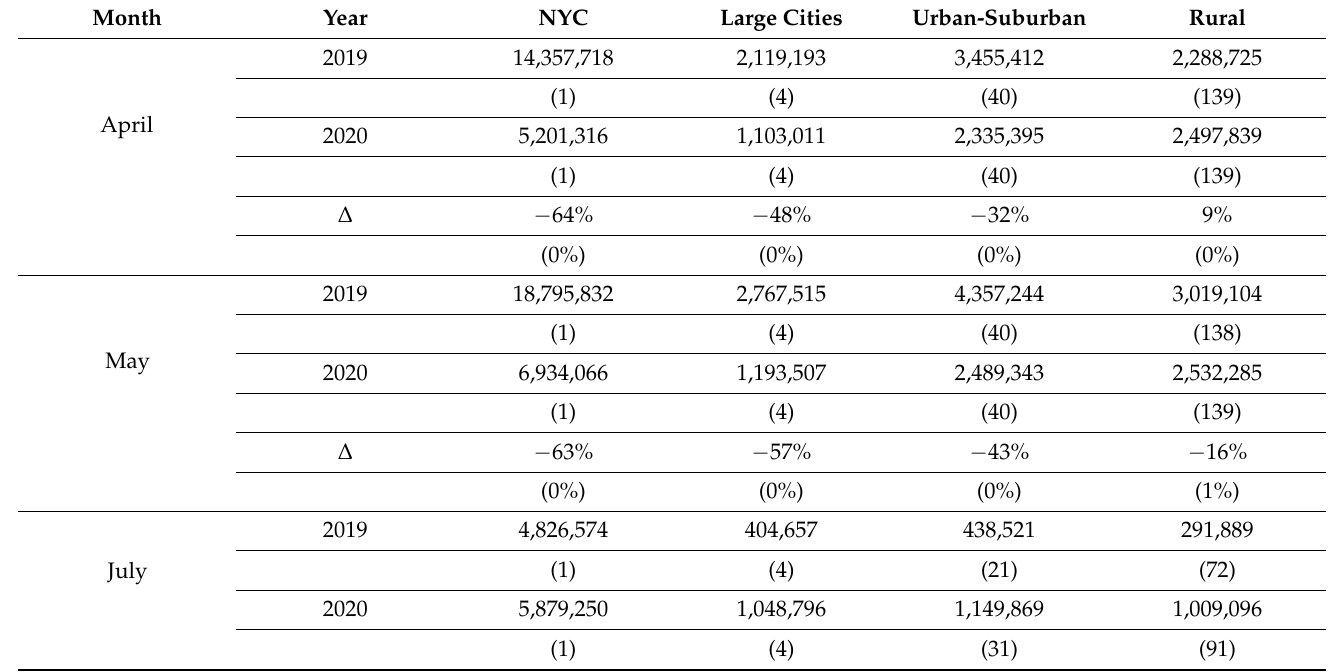
Table 2. Total meal count (SFA Count) by high-need district